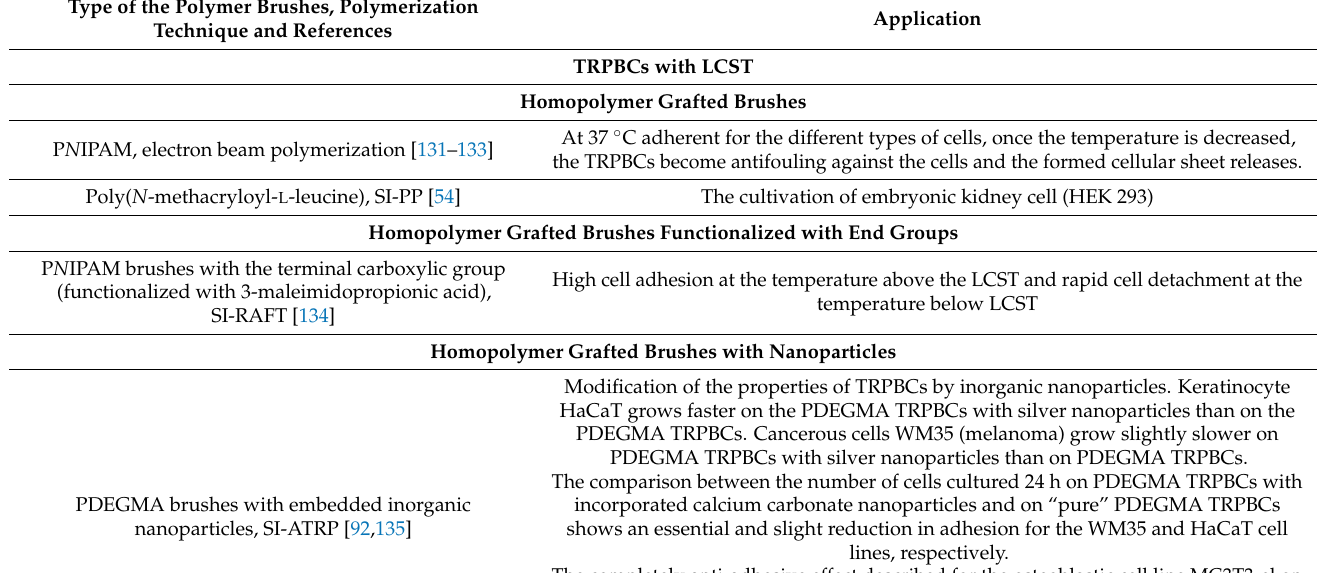
Table 4. Summarized information about TRPBCs for cell culture, cell separation, and temperature- stimulated cell and tissue